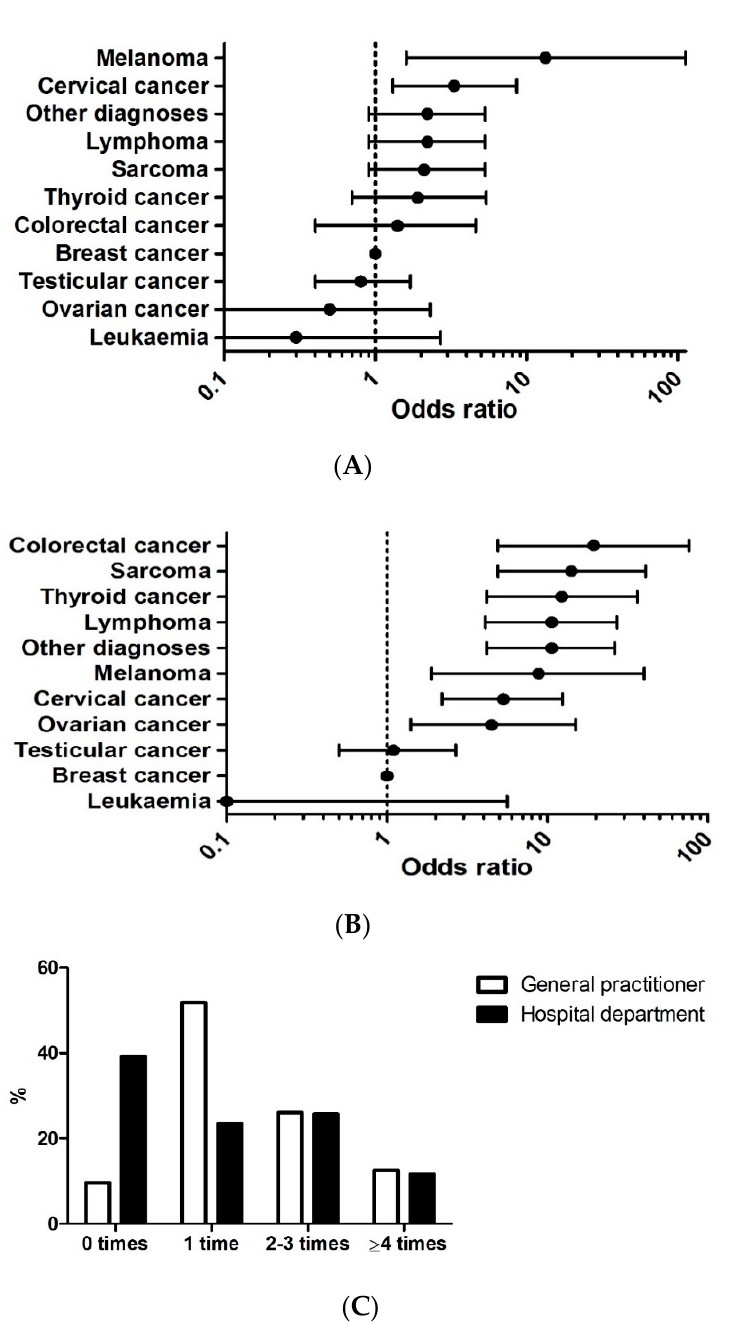
Figure 2. ( A ) Odds ratios of patient interval ≥ 1 month by diagnosis. ( B ) Odds ratios of healthcare interval ≥ 1 month by diagnosis. ( C ) Number of pre-diagnosis consultations. Table 2. Participant characteristics by interval length.